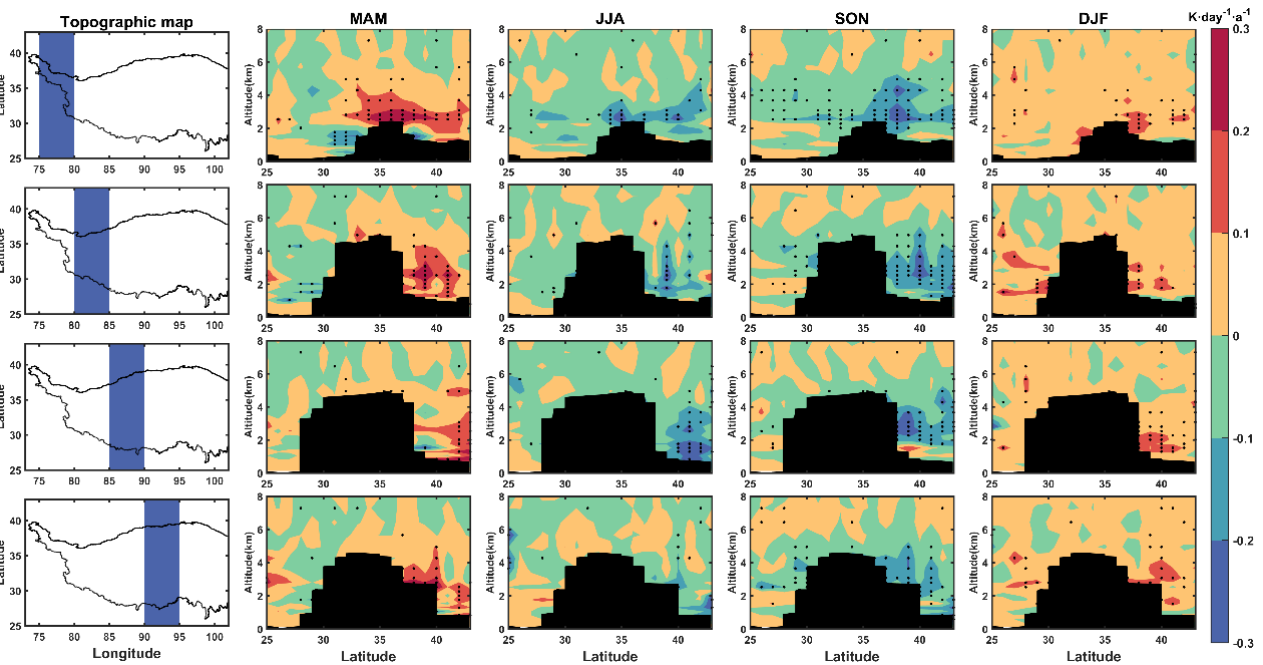
Figure 13. Distributions of linear annual trends of the seasonal SW DHRs during 2007 − 2020 on four longitudinal transects. The black point represents the linear trend passing the significance test at the level of 0.05.